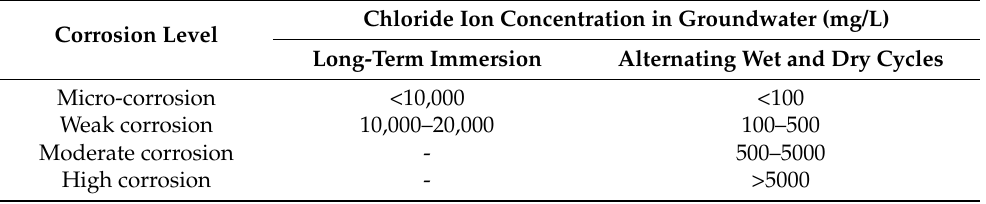
Table 1. Evaluation of chloride ion concentration on corrosion of steel reinforcement.